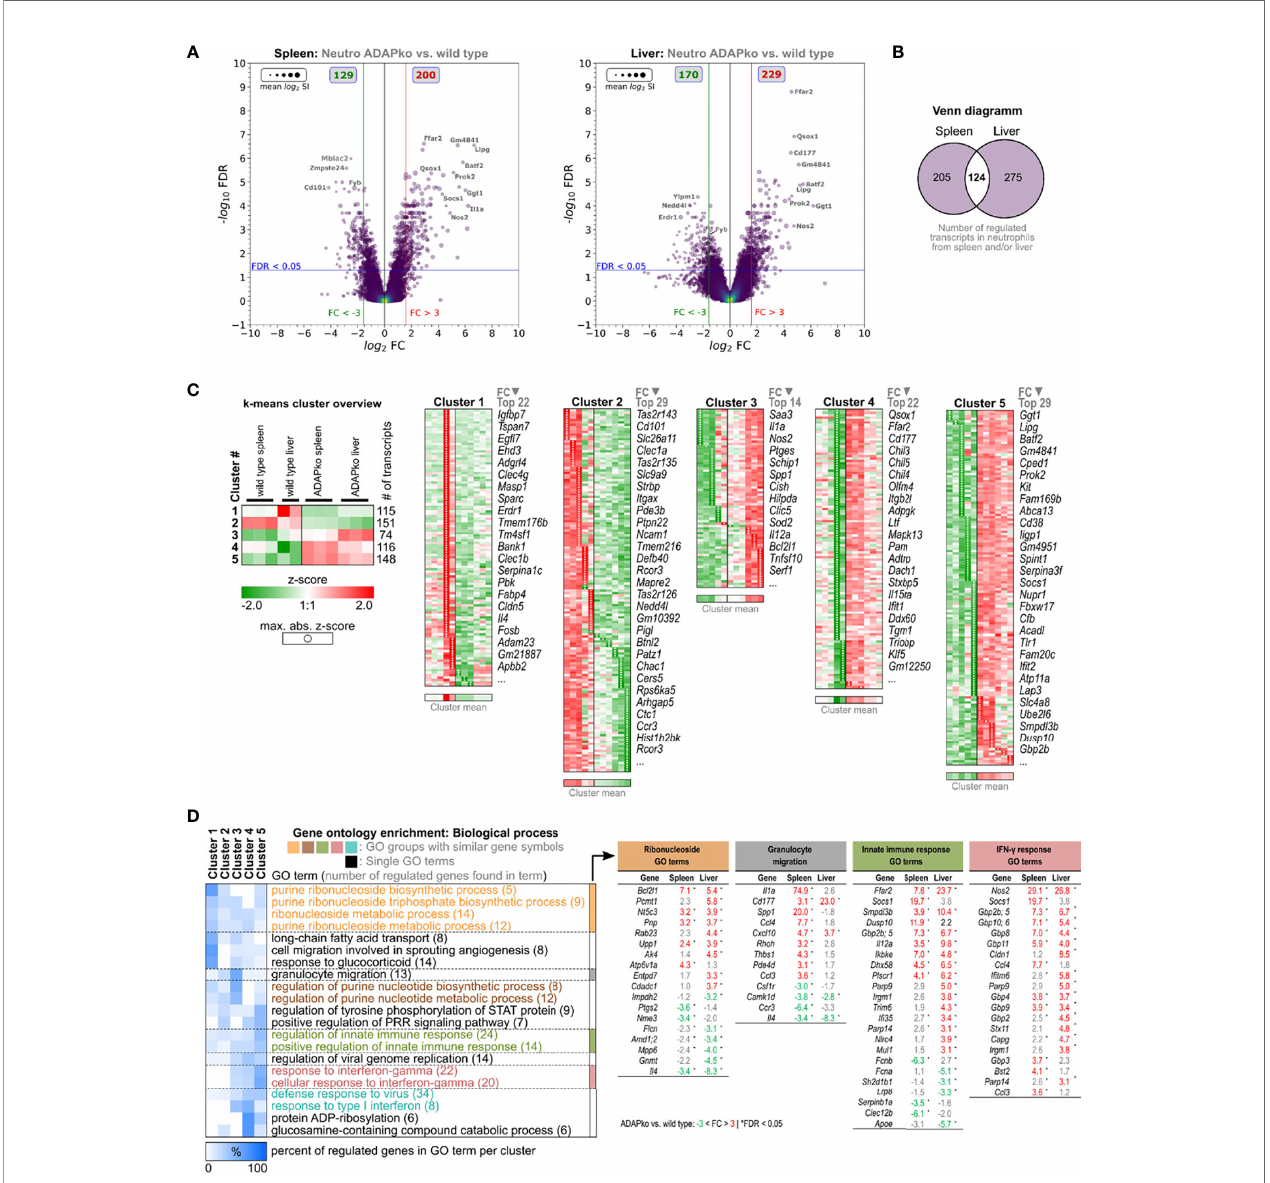
FIGURE 4 | ǀ Microarray analysis of neutrophils from the spleen and liver of wild type and ADAPko mice 3 days post in vivo Listeria monocytogenes ( Lm ) infection. Wild type and ADAPko mice (age: 9 – 15 weeks) were infected i.v. with 2.5 × 10 4 CFU Lm (strain 10403S) and sacri fi ced on day 3 post infection. Neutrophils (Ly6G + CD11b + cells) were FACS-sorted from the spleen and liver. Per genotype and organ, neutrophils from six mice were isolated, and cells from two mice each were pooled, resulting in n = 2 – 3 independent replicate sample pools per organ and genotype. Total RNA was isolated and analyzed by Clariom S microarray (23 samples in total). Differentially expressed transcripts in spleen-/liver-derived neutrophils were determined comparing ADAPko versus wild type condition (fold change > ± 3-fold, FDR < 0.05). (A) Volcano plots of validly detected transcripts from indicated microarray comparisons, plotting − log 10 FDR versus log 2 fold change. Point sizes refer to mean log 2 signal intensities (SIs) of transcripts calculated across all microarrays. Point color code re fl ects point density. FC (red/green vertical lines) and FDR (blue horizontal lines) criteria for differential gene expression are indicated. Gray boxes show numbers of signi fi cantly upregulated (red) and downregulated (green) transcripts. Gene symbols of selected transcripts are stated. (B) Venn diagram of 604 transcripts, differentially regulated in neutrophils isolated from the spleen or liver comparing ADAPko versus wild type condition, respectively. (C) Log 2 SI data of the 604 transcripts were z-score transformed and k-means clustered (k = 5), and transcripts in resulting clusters were descendingly sorted by maximal absolute z-score (marked by black point indicators). Data represent color-coded z-scores. Stated gene symbols in each cluster are descendingly ranked by average absolute FC, showing the top n symbols. Top left sub fi gure: averaged representation of k-means clusters. Sample type, cluster ID, and numbers of genes per cluster are indicated. (D) Gene Ontology (GO) enrichment analysis for GO category “ Biological Process ” (FDR < 0.05, GO level ≥ 8). GO term groups with the highest signi fi cance and numbers of overrepresented genes for ADAPko versus wild type are shown. Data represent hierarchically clustered percentages of enriched genes (color code) that fall into indicated k-means clusters. Numbers in brackets represent number of enriched genes per GO term. ADAPko, adhesion and degranulation-promoting adaptor protein knockout; CFU, colony-forming units; FACS, fl uorescence-activated cell sorting; FDR, false discovery rate; FC, fold